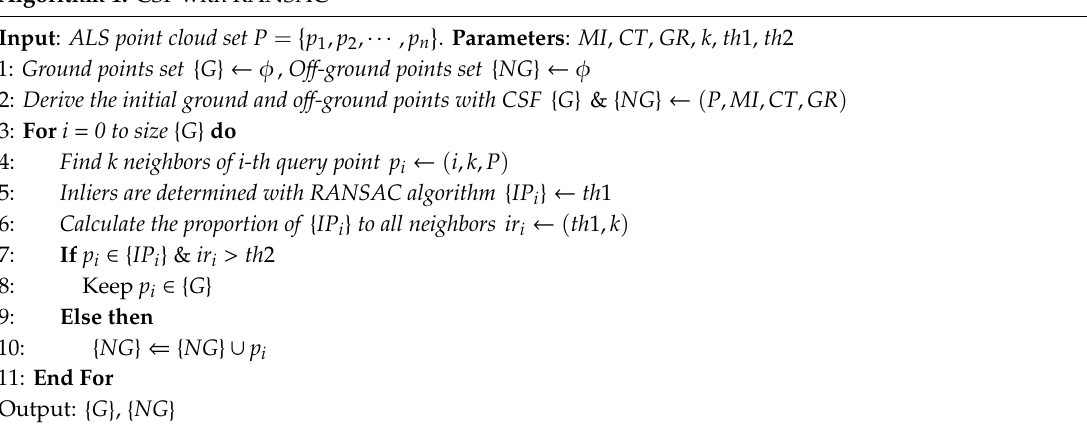
Algorithm 1. CSF with RANSAC